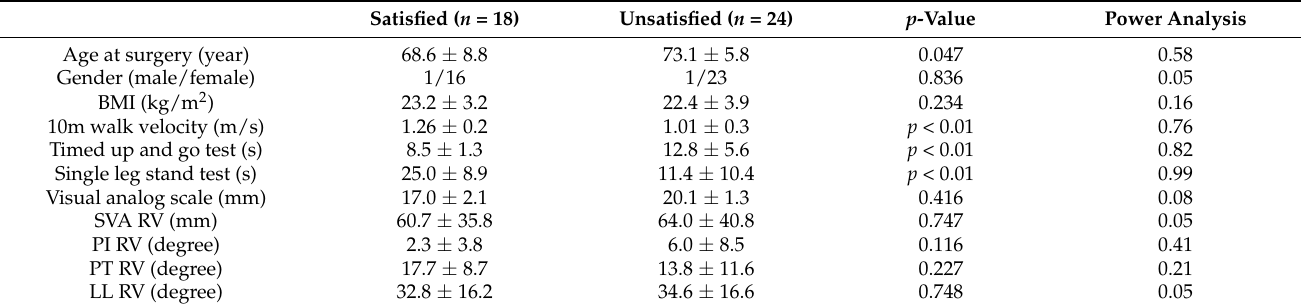
Table 4. Parameters of the two groups.